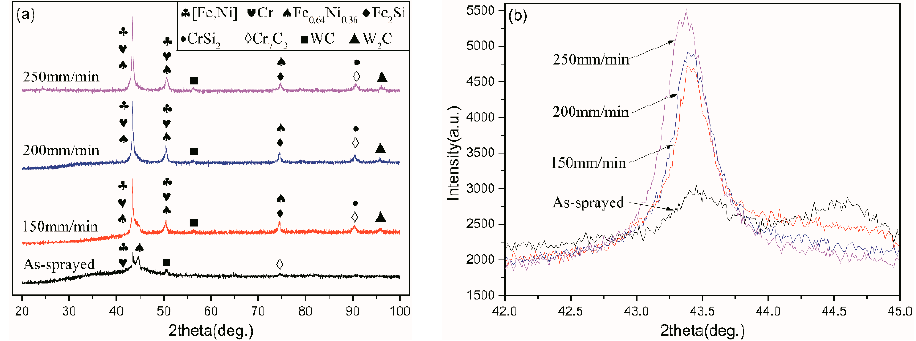
Figure 2. Patterns of ( a ) As-sprayed coating and di ff erent scanning speed remelting coating, and ( b ) the first primary Figure 2. patterns of ( a ) As-sprayed coating and different scanning speed remelting coating, and ( b ) the first primary peak.